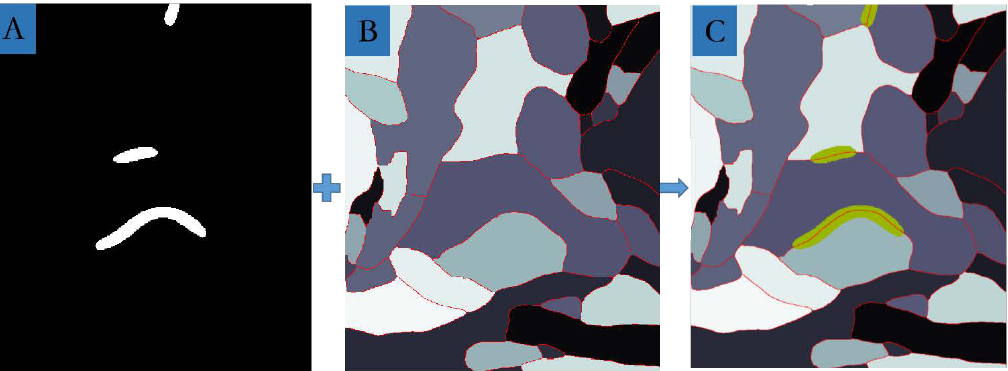
Figure 9. The workflow of MSB identification. ( A ) Mask of synapses; ( B ) segmentation of neurons; ( C ) mask of synapses superimposed on the segmentation of